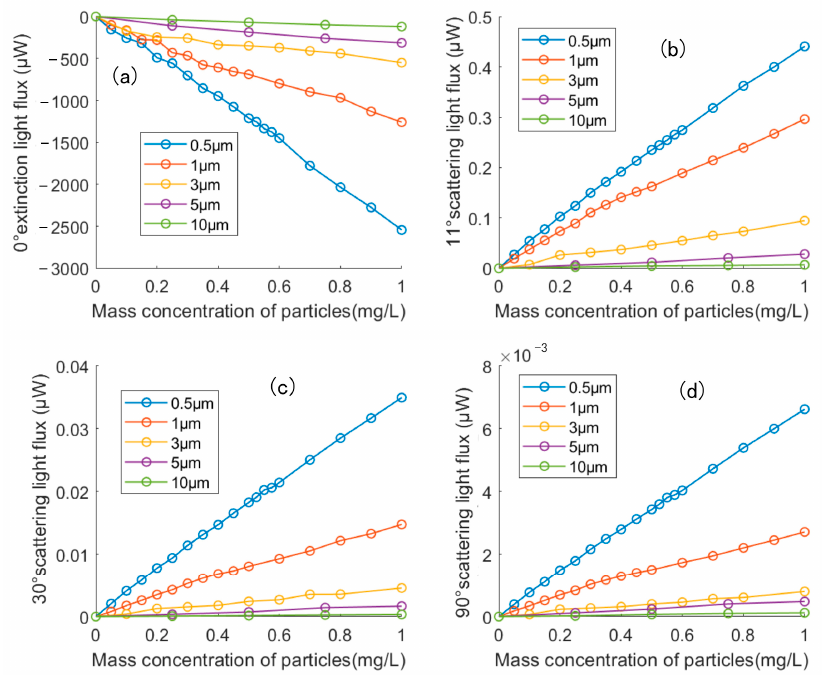
Figure 15. The relationship drawing of mass concentration and light flux of copper particles with different particle sizes at ( a ) 0° ( b ) 11° ( c ) 30° and ( d ) 90°. The slope of copper particles with average particle size of 0.5 μ m, 1 μ m, 3 μ m, 5 μ m and 10 μ m was fitted exponentially to the equivalent particle sizes. The most important parameter in the linear relationship was the slope, and the slope curves of the light flux- mass concentration relationship at different copper particle sizes were shown in Figure 16. The R 2 was above 0.99 and the trend of variation was similar to that of the simulation results, which was consistent with the theoretical calculation.